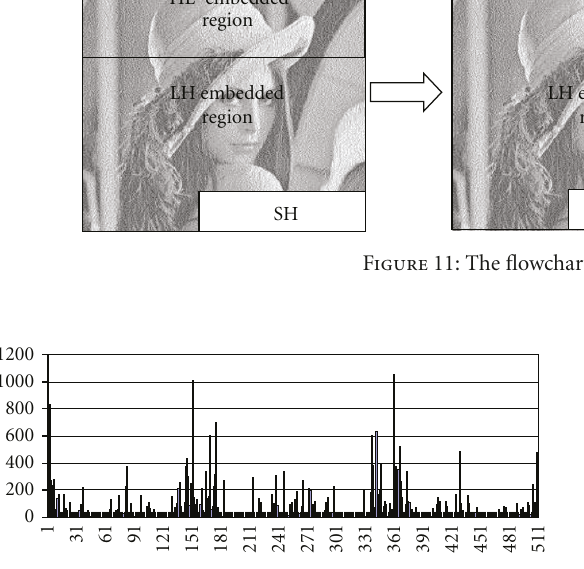
Figure 12: The pattern histogram of halftone image